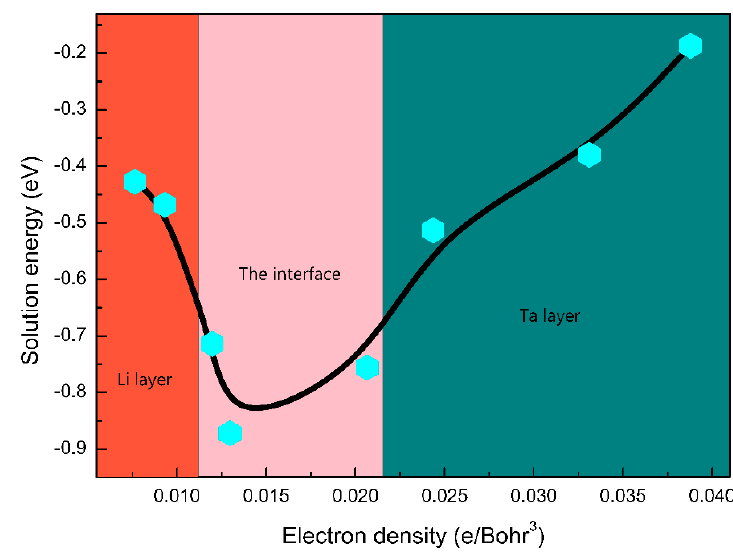
Figure 5. The solution energy of the H atoms as a function of the electron density in the Li/Ta bilayer (the ZPE correction is not considered here).